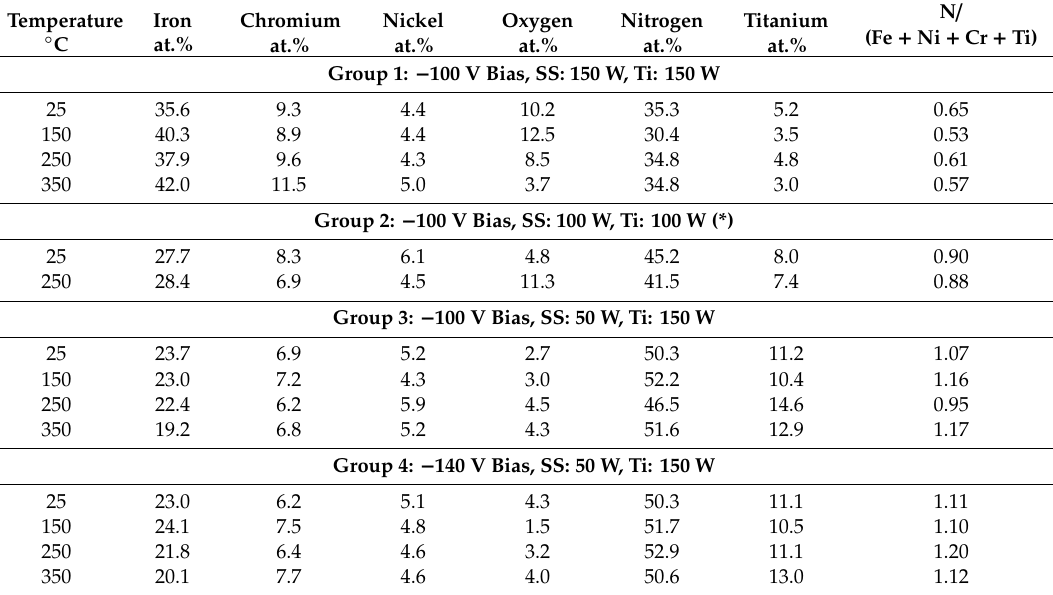
Table 1. Deposition parameters and film compositions for the SS-Ti-N